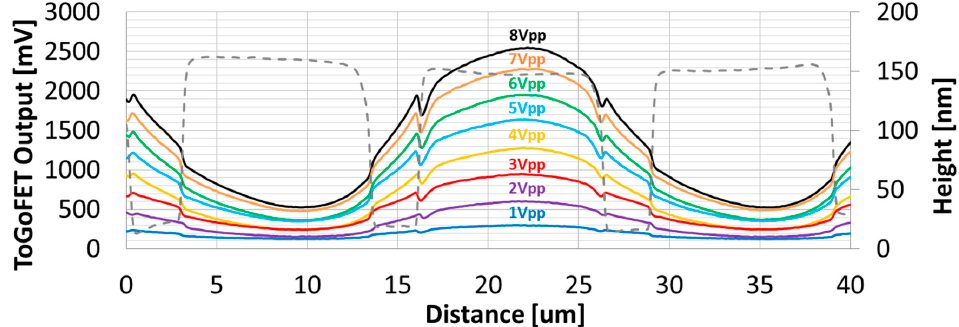
Figure 5. Line profiles of the ToGoFET signal in the direction perpendicular to electrodes covered with 400-nm-thick oxide. The input voltage of each line profile is shown.